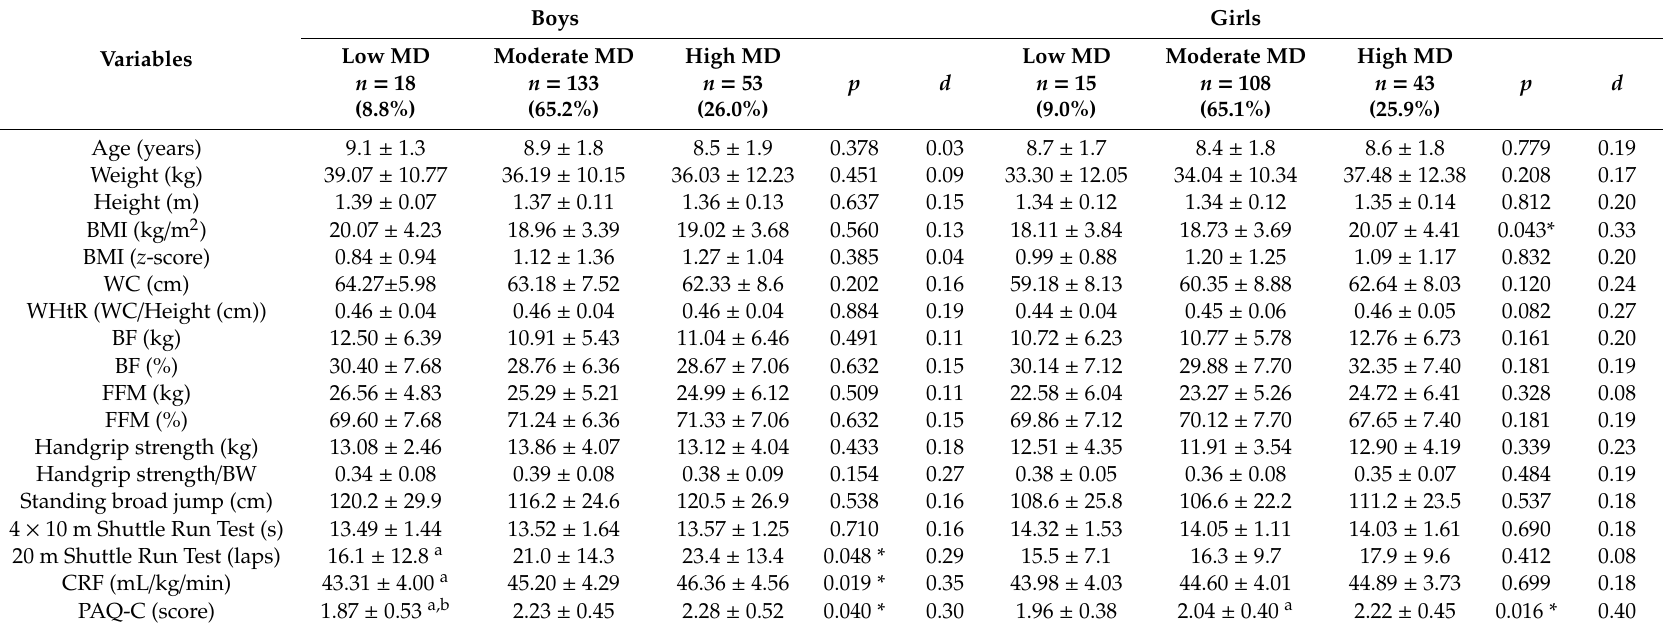
Table 1. Sample descriptive data according to adherence to the Mediterranean